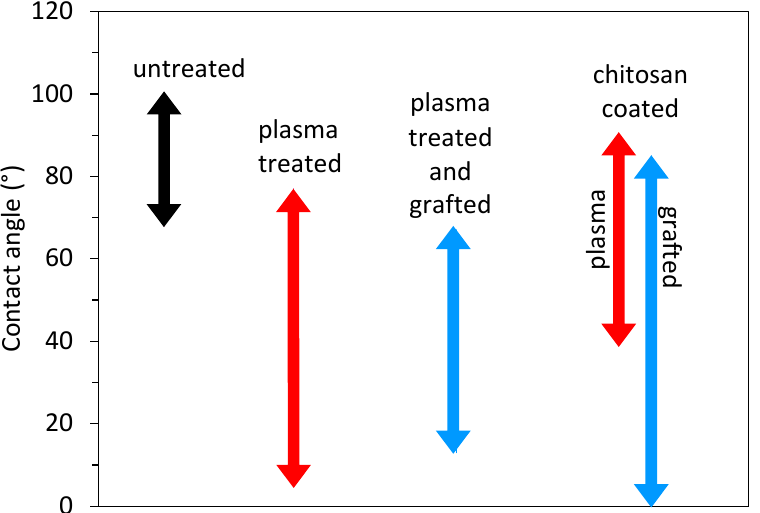
Figure 7. Reported wettability of the untreated substrate materials (black arrow), plasma-treated substrates (red), grafted substrates (blue), and chitosan-coated substrate (red for plasma-treated substrates and blue for grafted substrates).